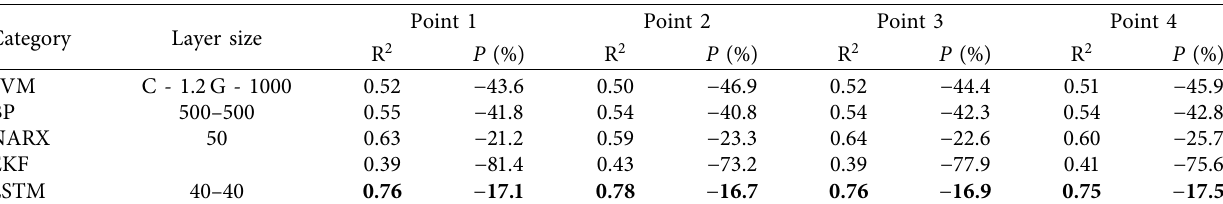
Table 3: Performance of different